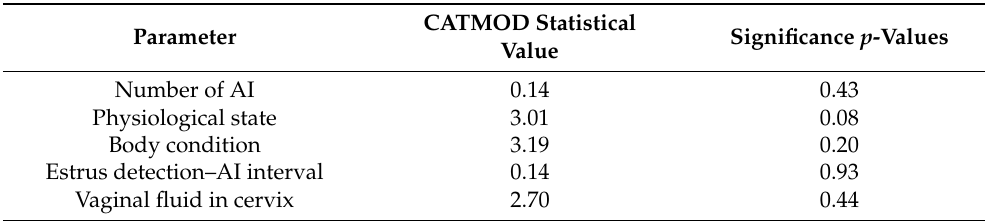
Table 2. CATMOD results for correlations between factors and fertility in organic Churra ewes in Spain. CATMOD Statistical Significance p -Values Parameter Value Number of AI 0.14 0.43 Physiological state 3.01 0.08 Body condition 3.19 0.20 Estrus detection–AI interval 0.14 0.93